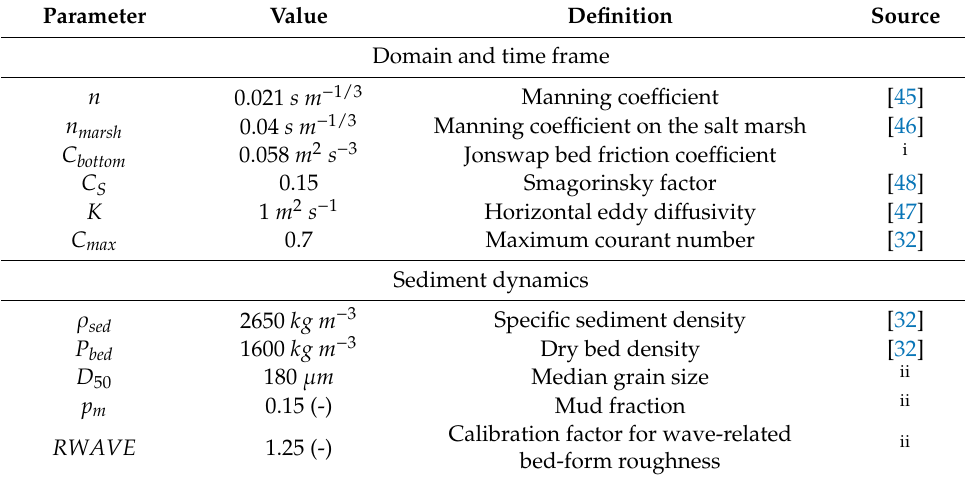
Table A1. Overview of the applied input